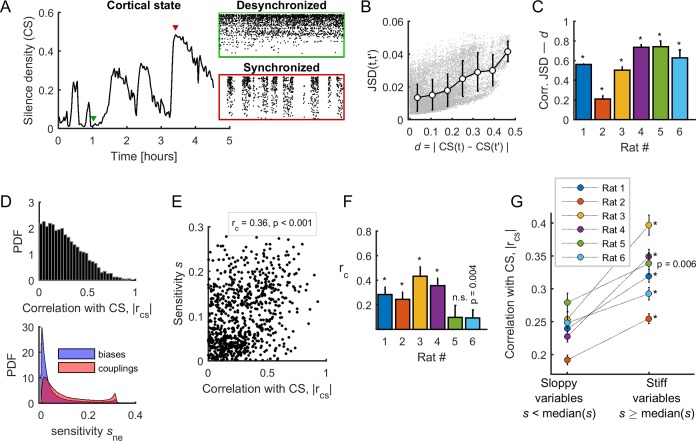
Spontaneous neuronal activity evolved along stiff dimensions during cortical state transitions.(A) Silence density was used to characterize the cortical state. Green inset: low values of the silence density indicate desynchronized cortical states (each row represents the spike train of a single-unit). Red inset: high values of the silence density indicate synchronized cortical states. Data from rat 1. (B) Difference in collective pattern statistics, that is DJS, between different epochs, t and t', as a function of the corresponding difference in silence density, noted d. Each gray dot corresponds to a pair of epochs (t,t'). The solid line indicates the average relation between DJS and d; error bars indicate SD. Data from all neuronal ensembles from rat 1. (C) Correlation coefficient between DJS and d, for all rats. *: p < 0.001. (D) Top: Distribution of the absolute value of the correlations between the cortical state and the activity observables, noted rcs. Bottom: Distribution of parameter sensitivity values for biases (h parameters) and couplings (J parameters), for all models from all rats. (E) rcs vs. sensitivity s of all activity variables (i.e., firing rates and pairwise correlations). Correlation: rc = 0.36; p <0.001. Data from rat 4 (Npop = 72). (F) Correlation between rcs and the sensitivity for each dataset. *: p < 0.001. Error bars indicate correlation 95% confidence interval. (G) rcs for sloppy and stiff variables. *: p < 0.001, paired t-test. Error bars indicate SEM.